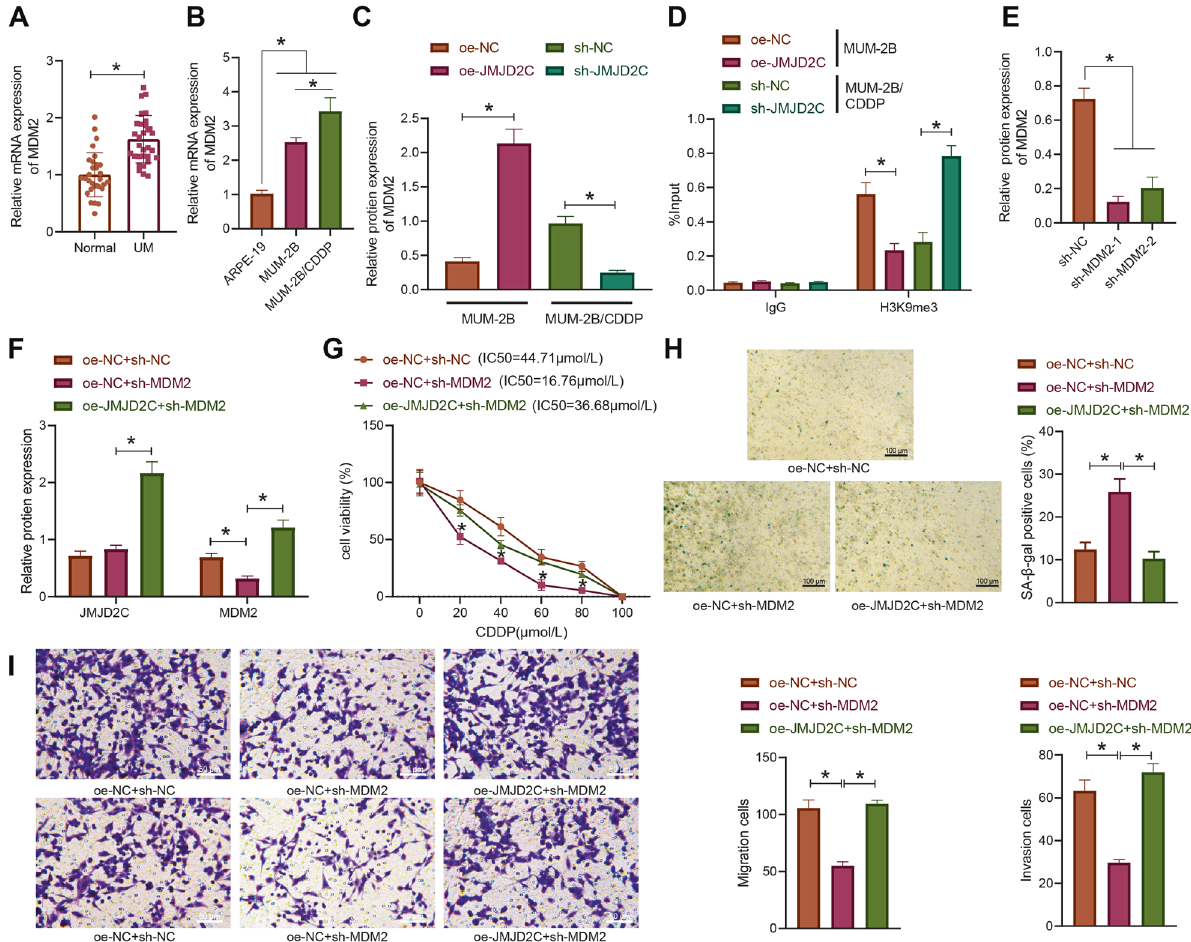
Fig. 3 JMJD2C promotes CDDP resistance in uveal melanoma cells by removing histone methylation of MDM2 promoter. A The expression of MDM2 in uveal melanoma tissues as determined by RT-qPCR (uveal melanoma = 32, normal = 30). B The expression of MDM2 in normal uveal epithelial cells ARPE-19, uveal melanoma cells MUM-2B, and drug-resistant cell line MUM-2B/CDDP as determined by RT-qPCR. C The expression of MDM2 in MUM-2B/CDDP cells after JMJD2C silencing and MUM-2B cells after JMJD2C overexpression as measured by Western blot assay. D Enrichment degree of H3K9me3 in MDM2 promoter region in MUM-2B/CDDP cells after JMJD2C silencing and MUM-2B cells after JMJD2C overexpression as determined by ChIP. E The expression of MDM2 silenced by shRNAs in MUM-2B/CDDP cells as measured by Western blot assay. F The protein expression of JMJD2C and MDM2 in MUM-2B/CDDP cells treated with sh-MDM2 or combined with oe- JMJD2C as measured by Western blot assay. G The viability and IC50 of MUM-2B/CDDP cells treated with sh-MDM2 or combined with oe- JMJD2C as assessed by CCK-8 assay. H The senescence rate of MUM-2B/CDDP cells treated with sh-MDM2 or combined with oe-JMJD2C as assessed by SA- β -gal staining. I The migration and invasion abilities of MUM-2B/CDDP cells treated with sh-MDM2 or combined with oe- JMJD2C as assessed by Transwell assay. * p < 0.05. Cell experiments were repeated three times